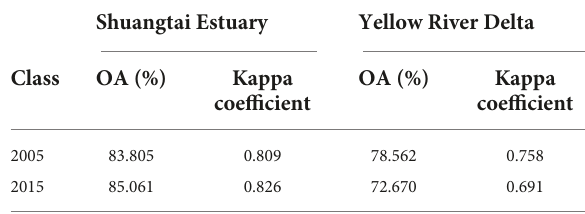
TABLE 3 The accuracy assessment of classification in north